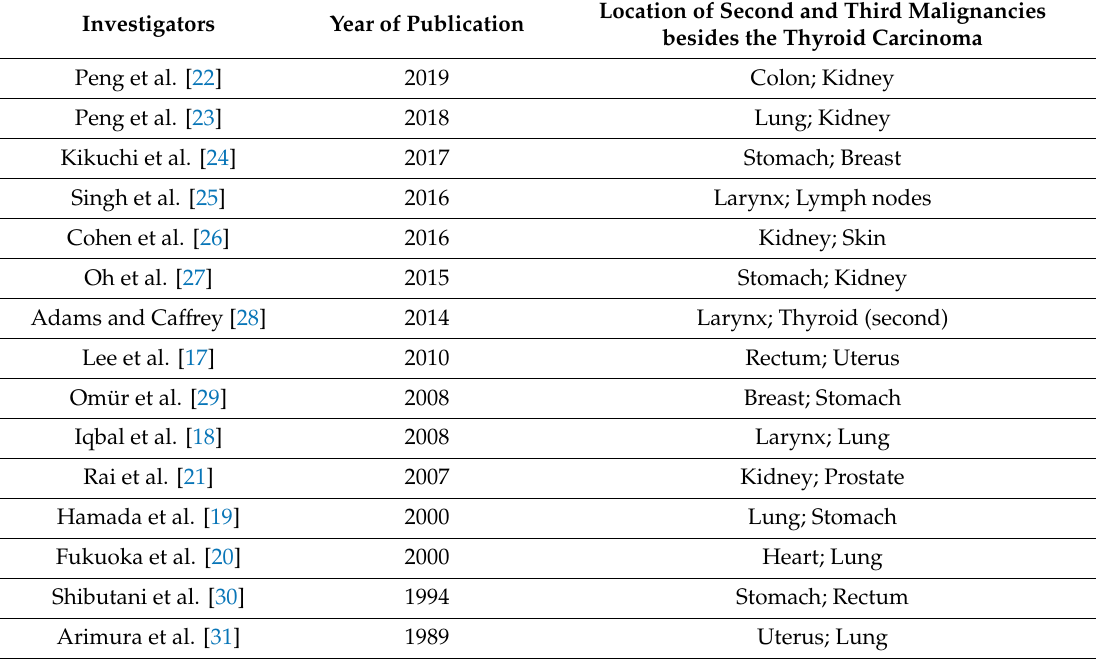
Table 2. Summary of Pubmed indexed articles of triple malignancies with thyroid